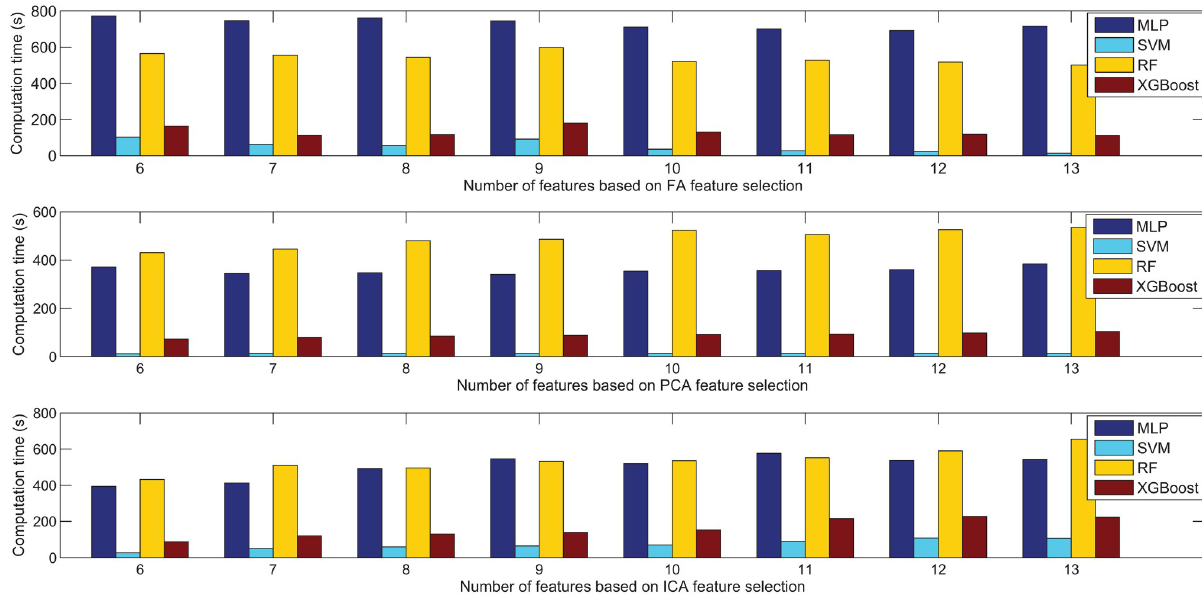
Fig 10. Comparison results in terms of computation time based on FA, PCA and ICA feature extraction for the StatLib dataset.